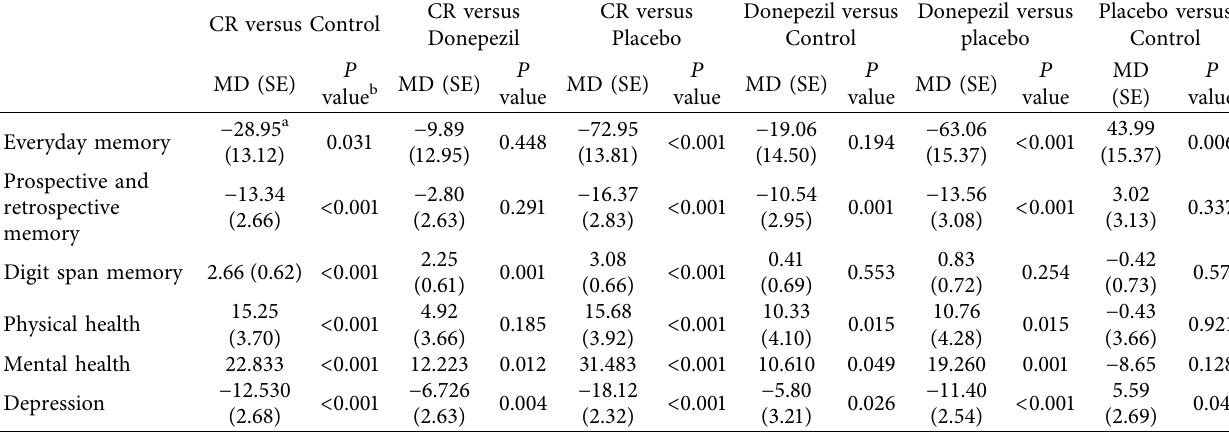
Table 3: Individual post hoc analyses of MANCOVA to find group differences among cognitive rehabilitation, donepezil, placebo, and control.